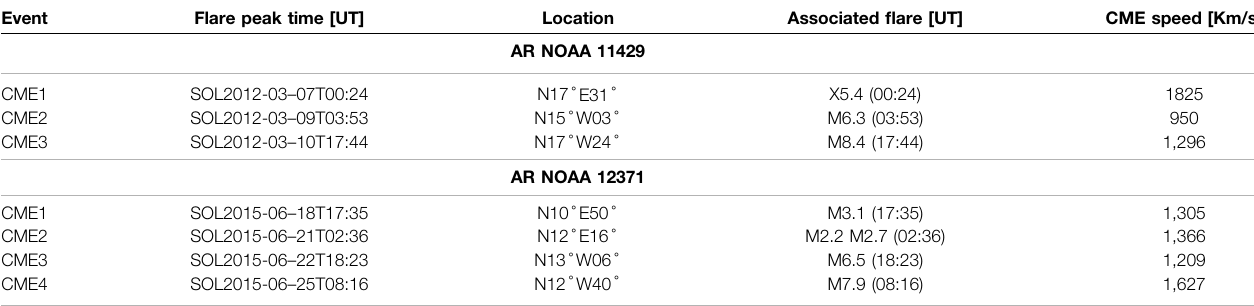
TABLE 1 | Information of CME eruptions and associated fl ares from the studied ARs.